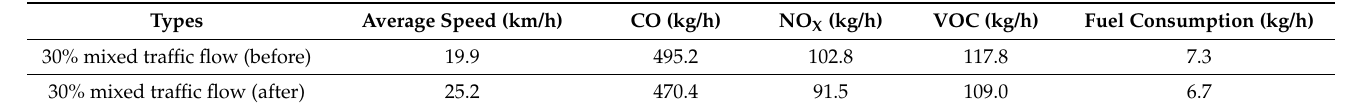
Table 6. Comparison of results of the sections.